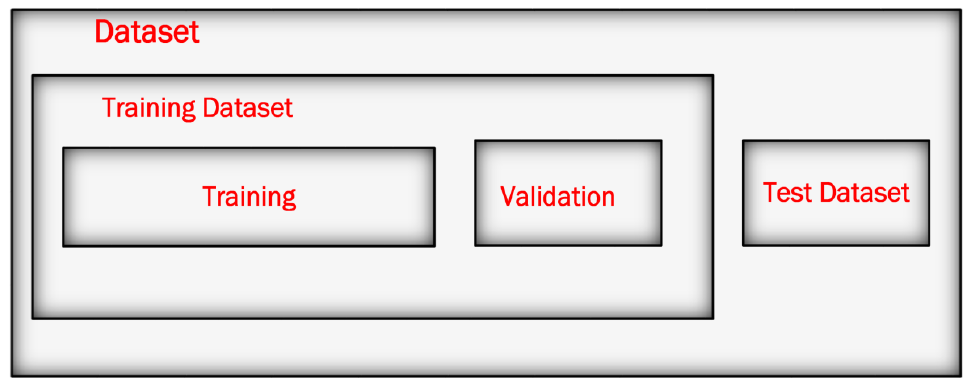
Figure 5. Block diagram for hybrid dataset distribution.